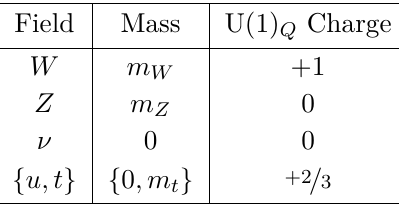
Table 1 . The loop field content (left table) and the couplings of those fields (right table). The matrix U ij is the two-generation quark-mixing matrix. Note that since we only consider two fermion generations inside the loop, the charged vector couplings need to be specified only for one generation — see text for